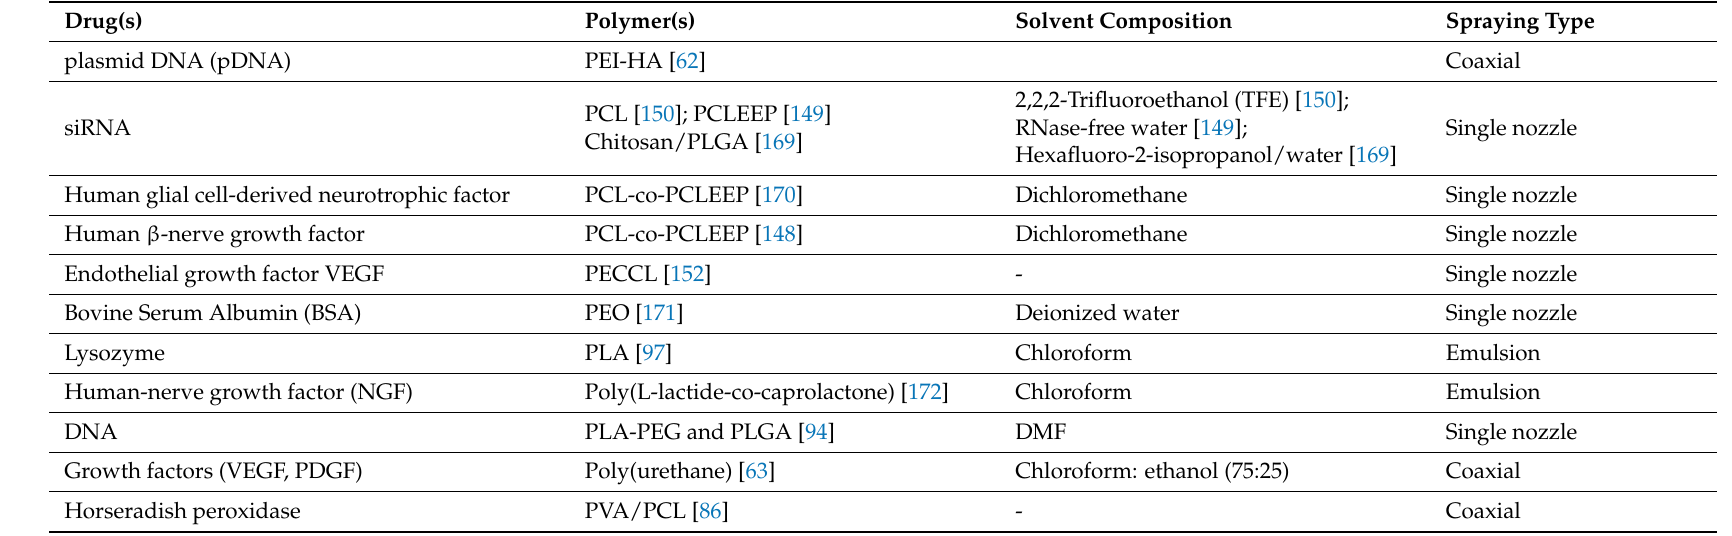
Table 2. Studies involving the use of electrospun fibers in delivery of proteins, DNA, RNA and human factors (partial listing).